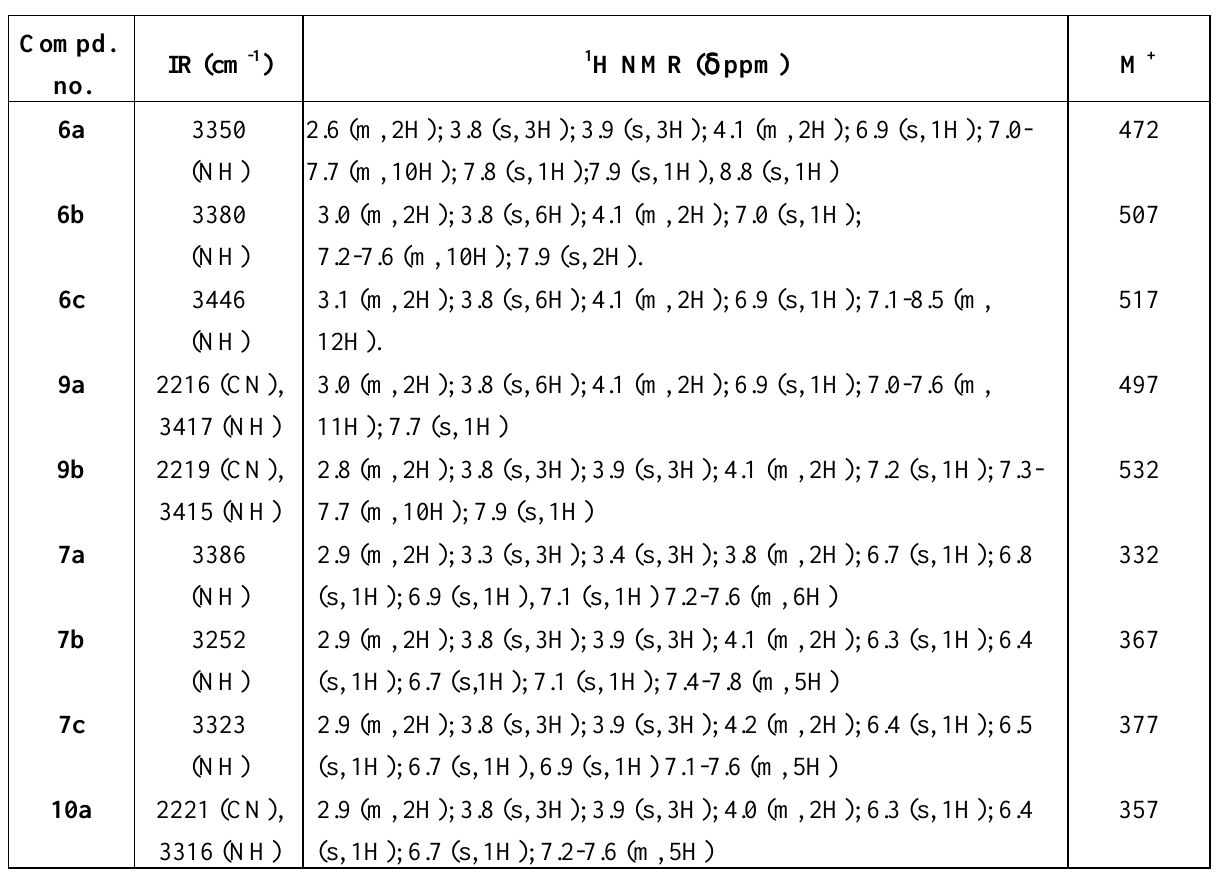
Table 2. IR and 1 H-NMR spectroscopic